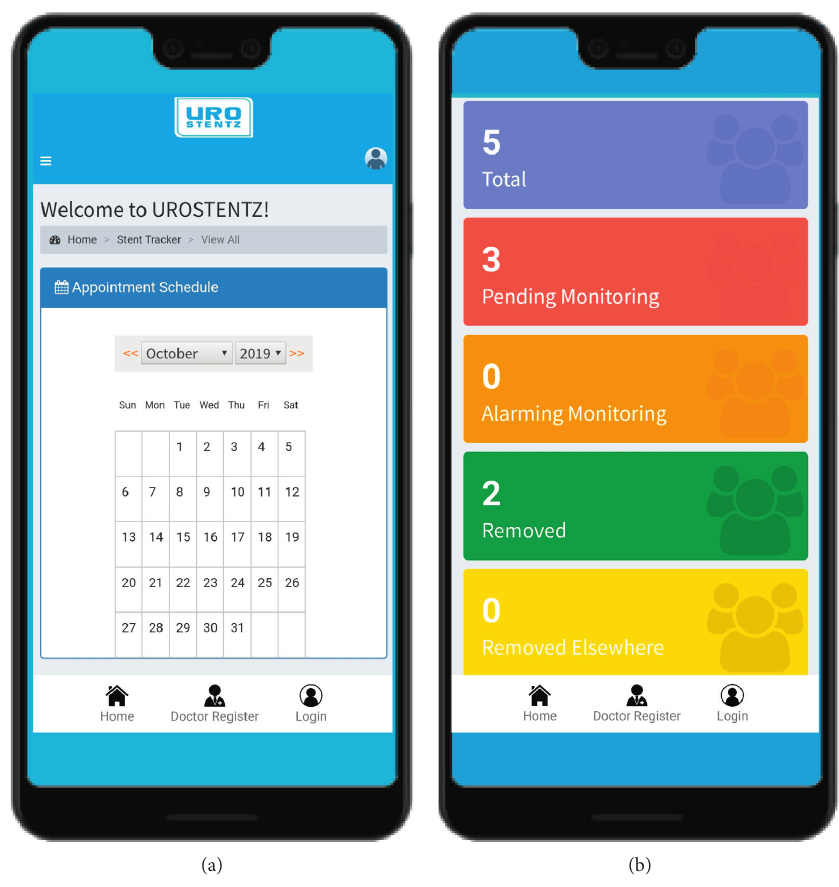
Figure 3: (a) Clinician dashboard to receive notifications regarding the total patients scheduled for stent removal on a day-to-day basis. (b) Clinician dashboard: updates regarding patient’s ureteral stent removal status (reproduced with the permission of de- velopers of the application (RAYZ